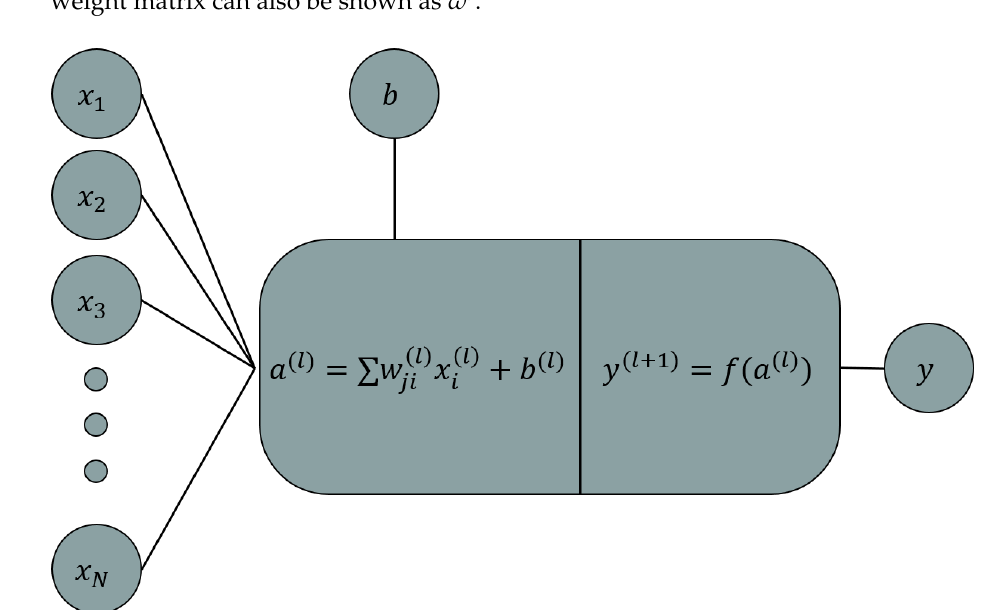
Figure 7. Neuron value